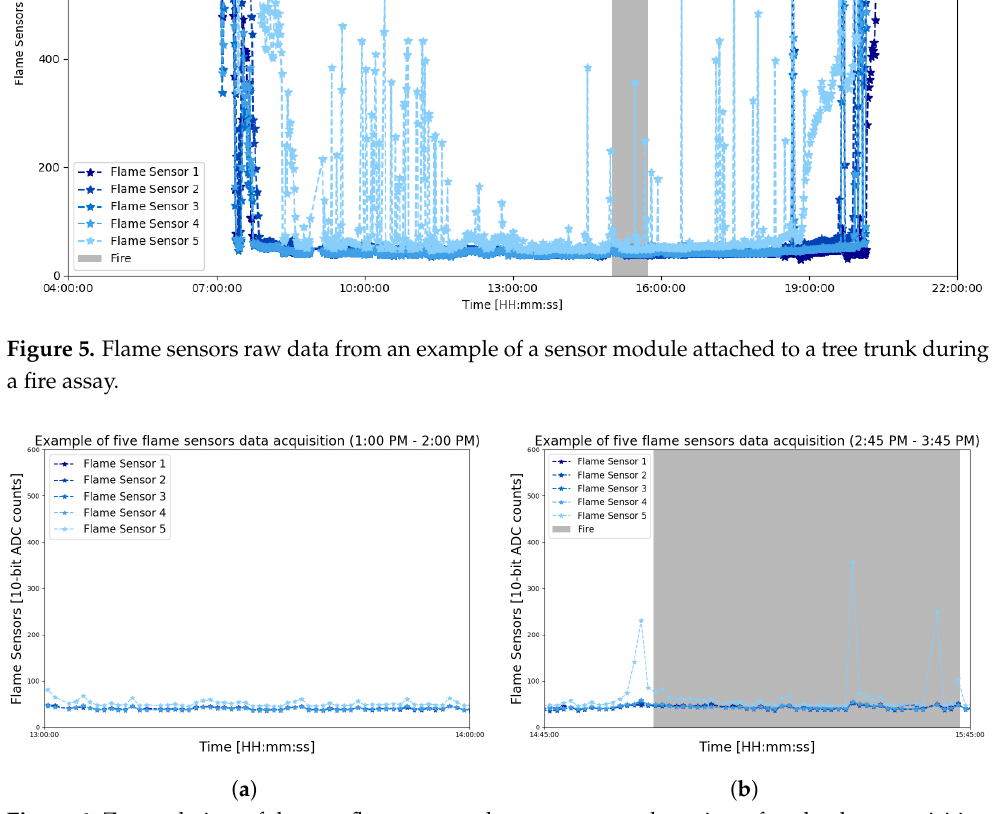
Figure 6. Zoomed view of the raw flame sensor data to compare the noises after the data acquisition of a fire test. ( a ) Noise in flame sensors without fire. ( b ) Noise in flame sensors with